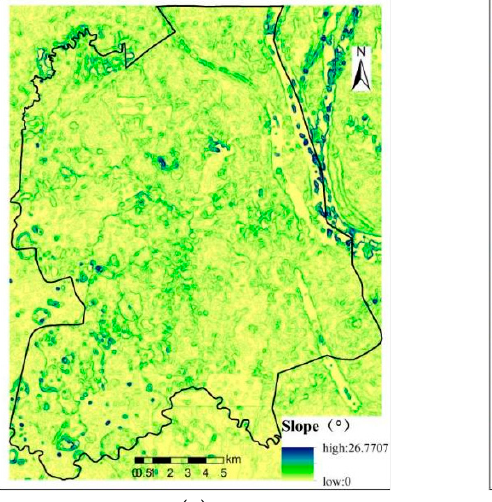
( c ) Figure 3. Buffer zone: ( a ) Buffer zone without religious POI; ( b ) Religious POI buffer zone; ( c ) Total forbidden construction zone.